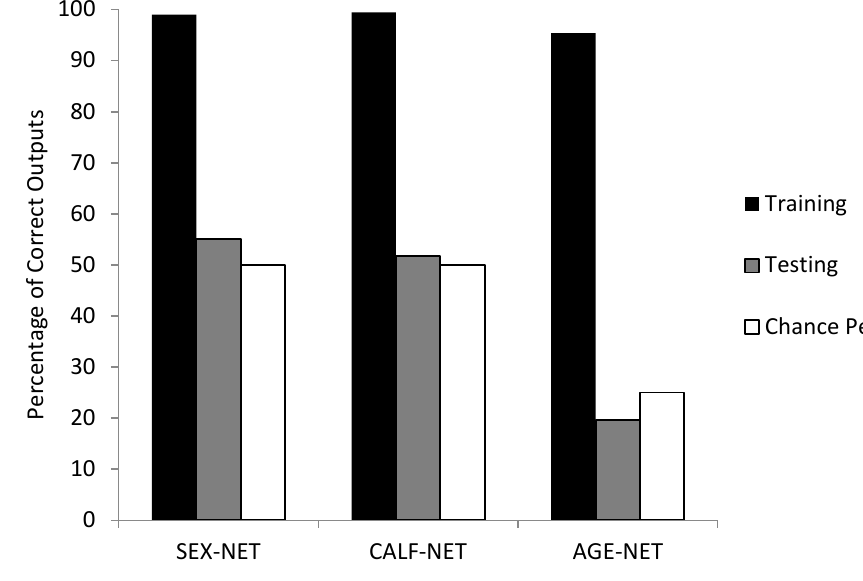
Figure 3. Accuracy for NN classifiers after training and in generalization